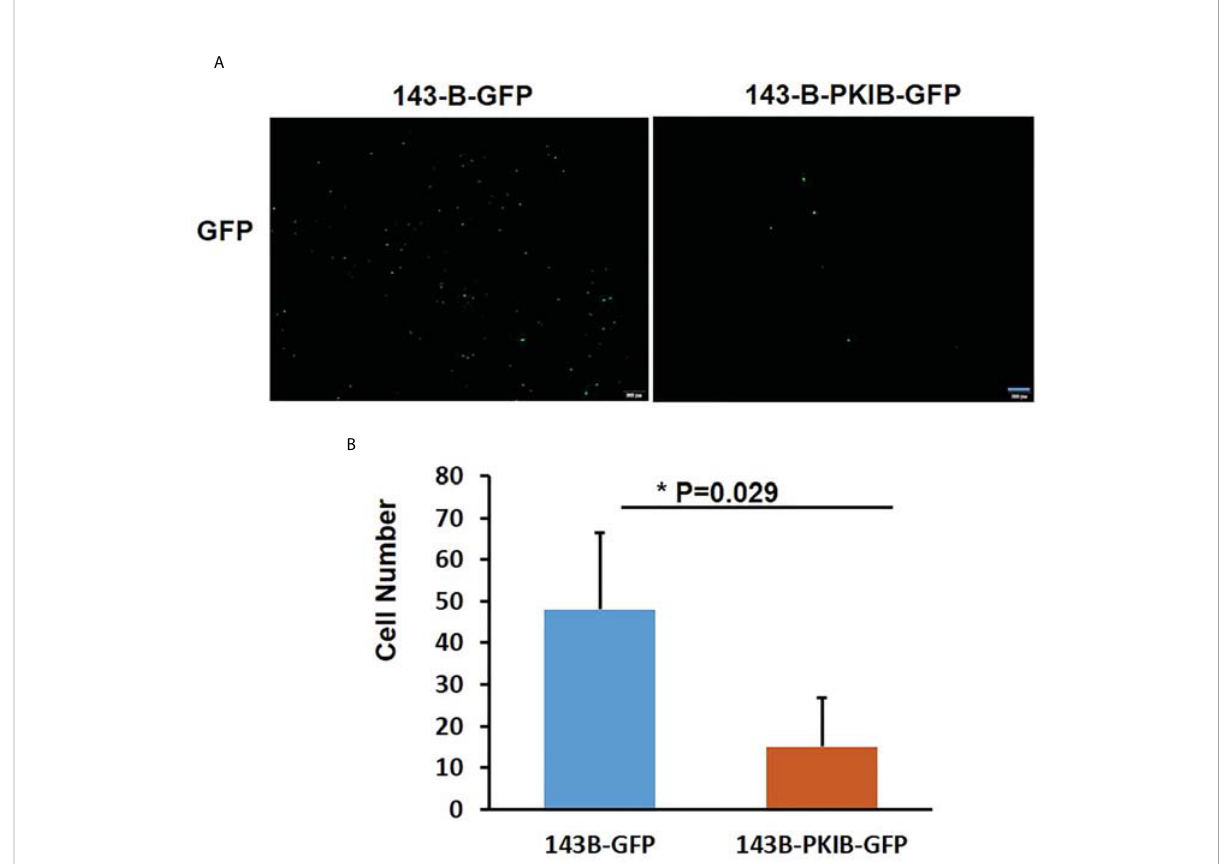
FIGURE 5 PKIB inhibits the invasion of osteosarcoma. (A) Representative images to show the 143-B-GFP and 143-B-PKIB-GFP cells invaded into lower chamber 12h after seeding on the upper chamber of transwell. (B) . Bar graph to show the average cell number invaded into lower chamber of transwell. n=4, Error bars: Mean±SD,